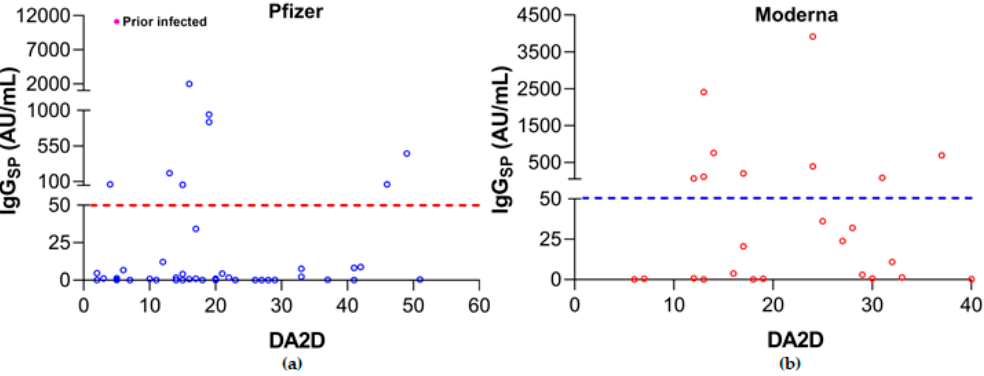
Figure 1. Frequency distribution of IgG SP versus days after the second dose of COVID-19 vaccines in LT recipients ( a ) BNT162b2 (Pfizer-BioNTech); ( b ) mRNA-1273 (Moderna). DA2D, days after the second dose of COVID-19 vaccines; prior-infected, pink-filled circle (Figure 1a); broken red and blue lines, IgG SP serology assay’s manufacturer-recommended positive cut-off